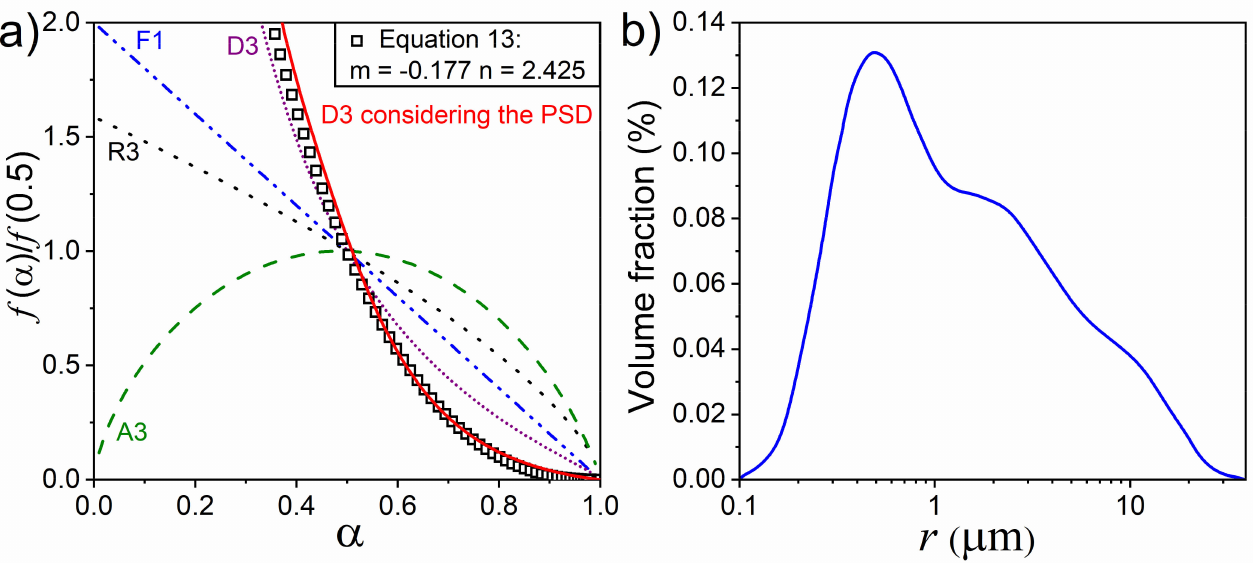
Figure 12. ( a ) Comparison between the Sestak–Berggren model obtained for the dehydroxilation of kaolinite, represented as open symbols, and some ideal kinetic models from the literature. The D3 kinetic model, modified considering the PSD is also included as a red solid line. ( b ) PSD of the kaolinite sample used in this